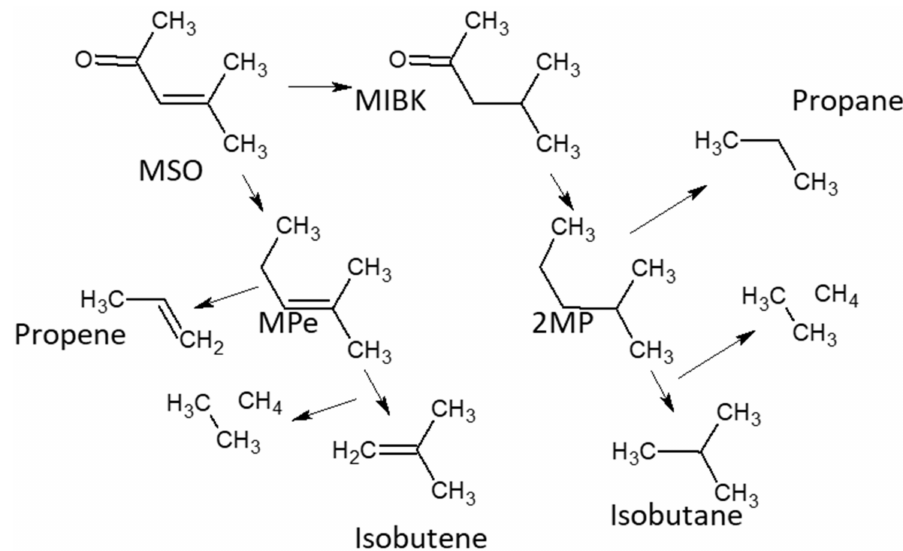
Figure 12. Proposed reaction scheme for the production of MIBK, 2MP, MPe, propene, propane, isobutene, and isobutane.